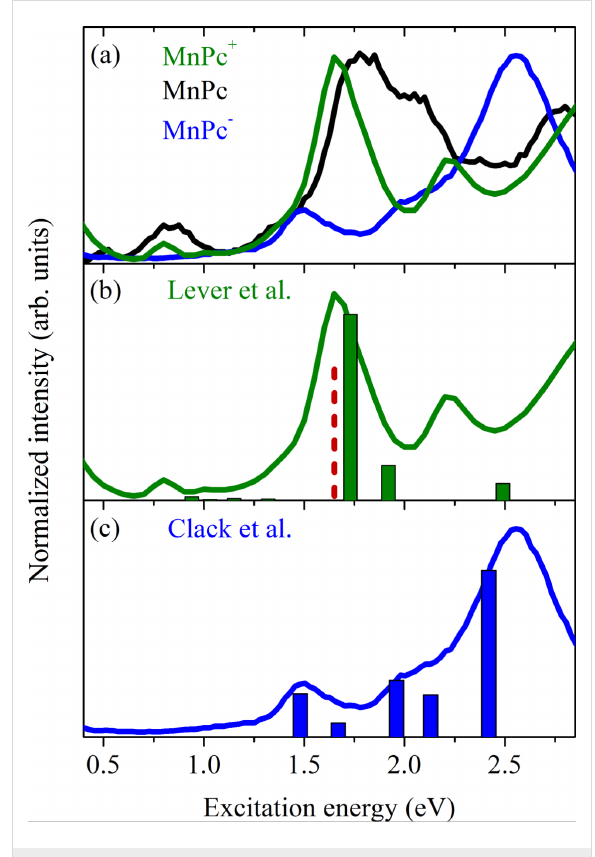
Figure 9: (a) Comparison of the electronic excitation spectra of MnPc, K 1 MnPc and MnPc/F 4 TCNQ as measured using EELS. In the lower two panels, we compare these data to the optical absorption energies (denoted by vertical bars) as observed for (b) MnPc + [117] and (c) MnPc − [118] in solution. In panel (b) we additionally show the optical absorption energy of F 4 TCNQ − radicals in solution (dashed line)